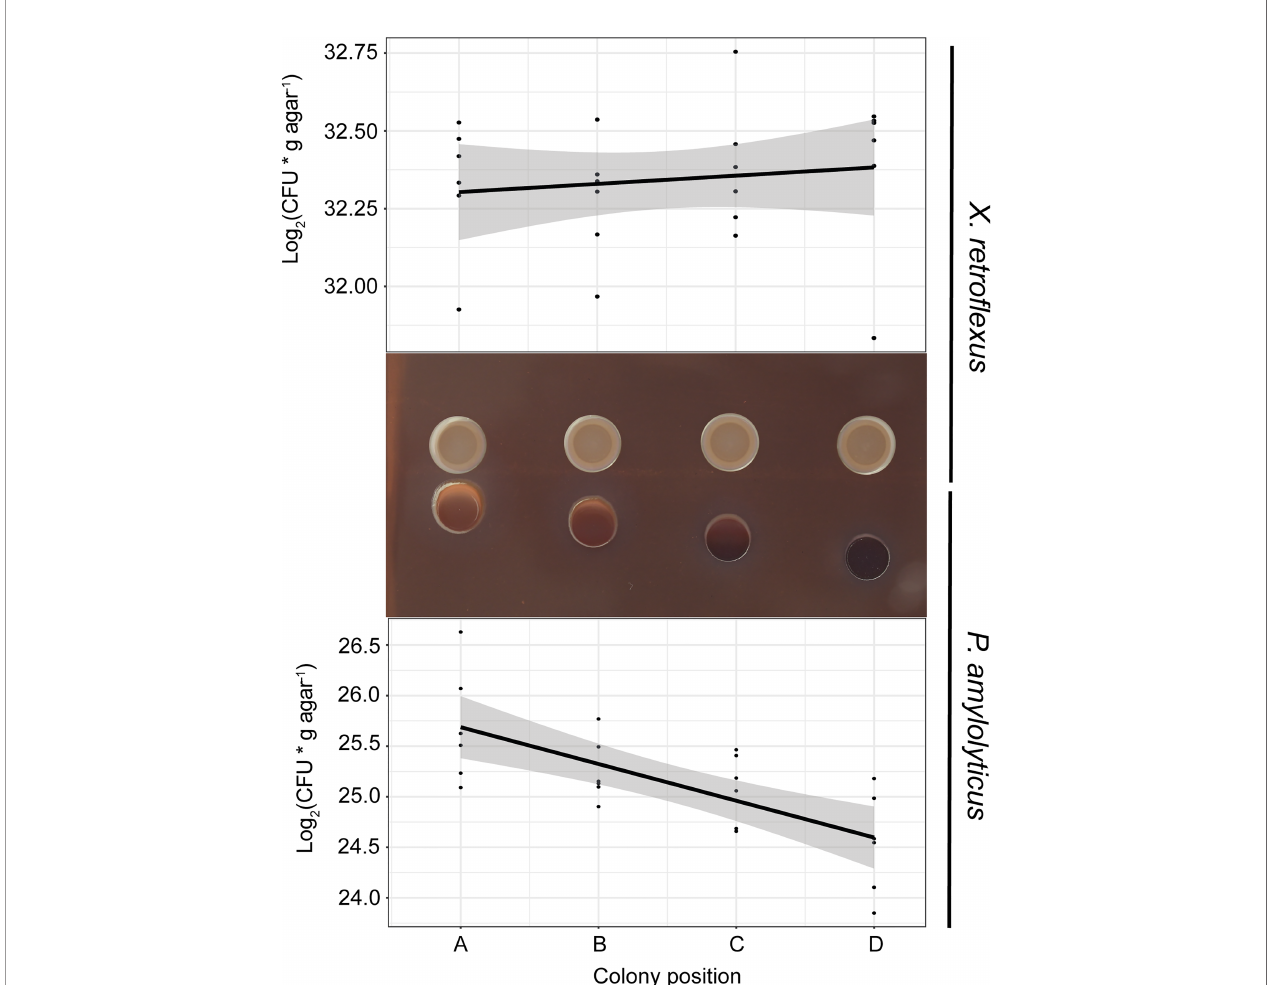
FIGURE 1 | Bacterial growth as a function of distance (position A – D ) between colonies of X. retro fl exus and P. amylolyticus . After 48 hrs of growth, X. retro fl exus induced colony growth and a change in colony morphology of P. amylolyticus with reduced distance between the colonies when cultured on 50% Congo red agar plates. The colony of P. amylolyticus became increasingly more red with closer proximity, and the periphery of the P. amylolyticus colony became disordered in texture and displayed directional growth towards X. retro fl exus . Log2(CFU* g agar-1) of P. amylolyticus was signi fi cantly lower with increasing distance, as calculated by a linear model (Coef fi cient; -0.36, R2 = 0.47, p-value = 0.00014). No signi fi cant linear trend was observed for X. retro fl exus colonies (Coef fi cient; 0.026, R2 = -0.025, p-value =